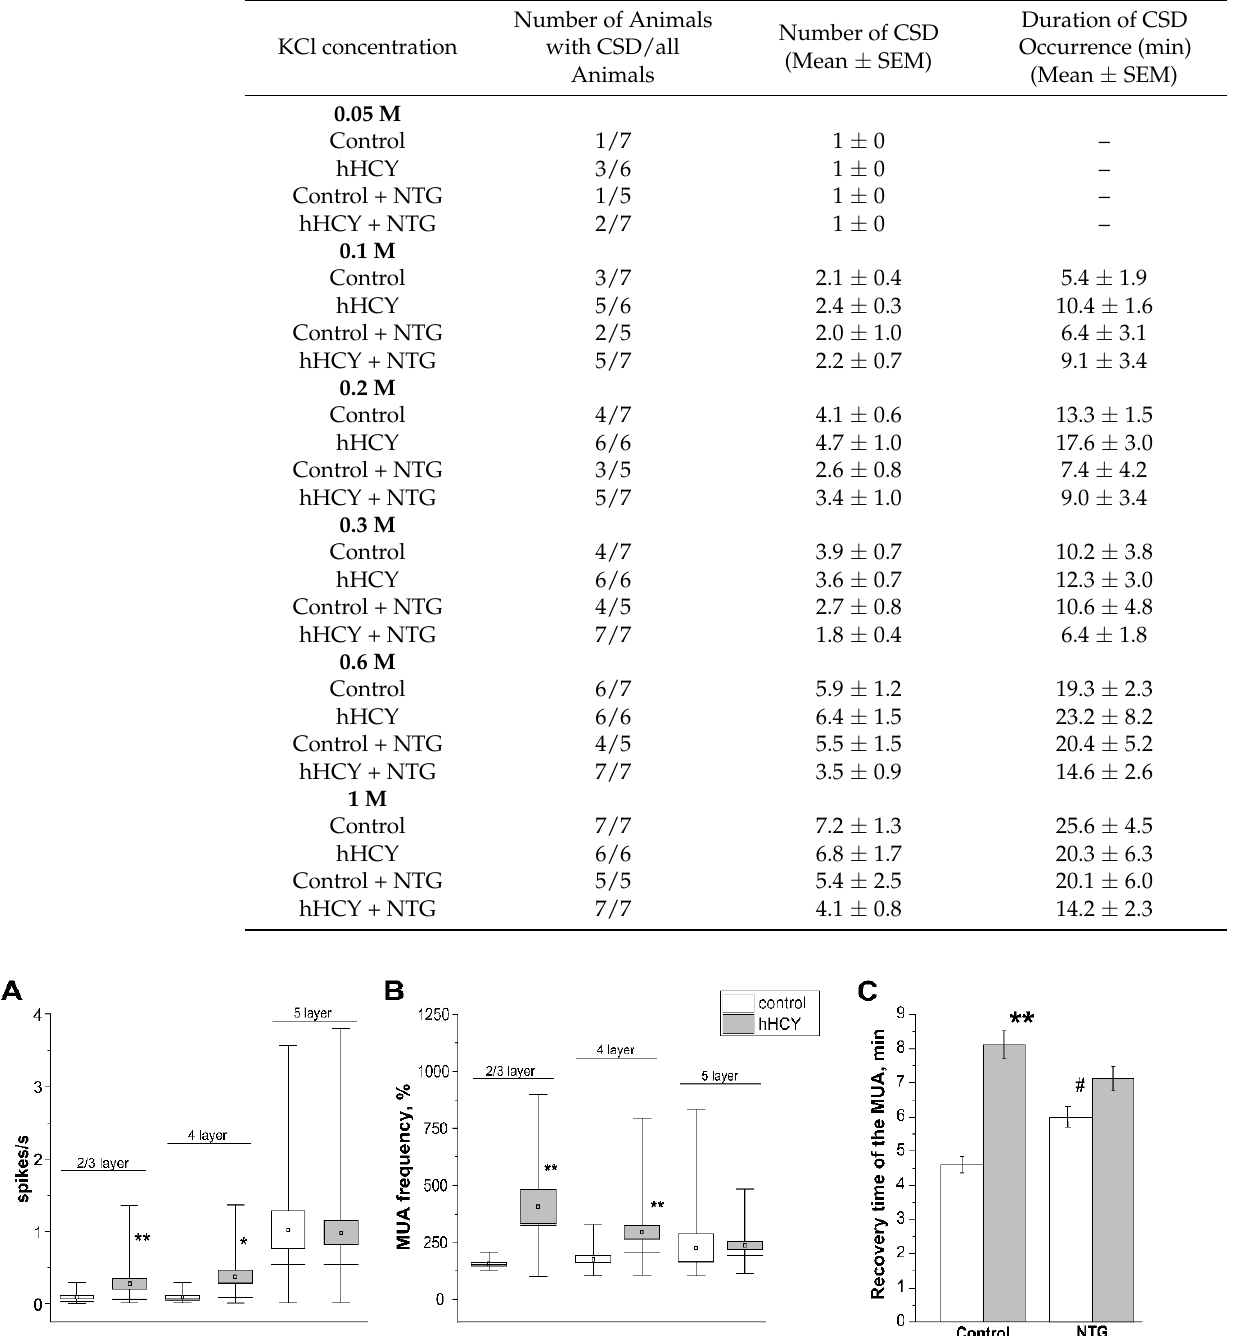
Figure 4. Effects of nitroglycerine (NTG) on MUA in rats of control and hHCY groups. ( A ) Back- ground MUA frequency before the administration of NTG in animals of the control (white boxplots) and hHCY (grey boxplots) groups, ( B ) increase in MUA (in %) after administration of NTG in animals of the control (white boxplots) and hHCY (grey boxplots) groups, ( C ) recovery time of MUA after CSD wave before and after injections of NTG in control (white columns) and hHCY (grey columns) groups. * p < 0.05, ** p < 0.01 compared to control, # p < 0.05 compared to initial values.